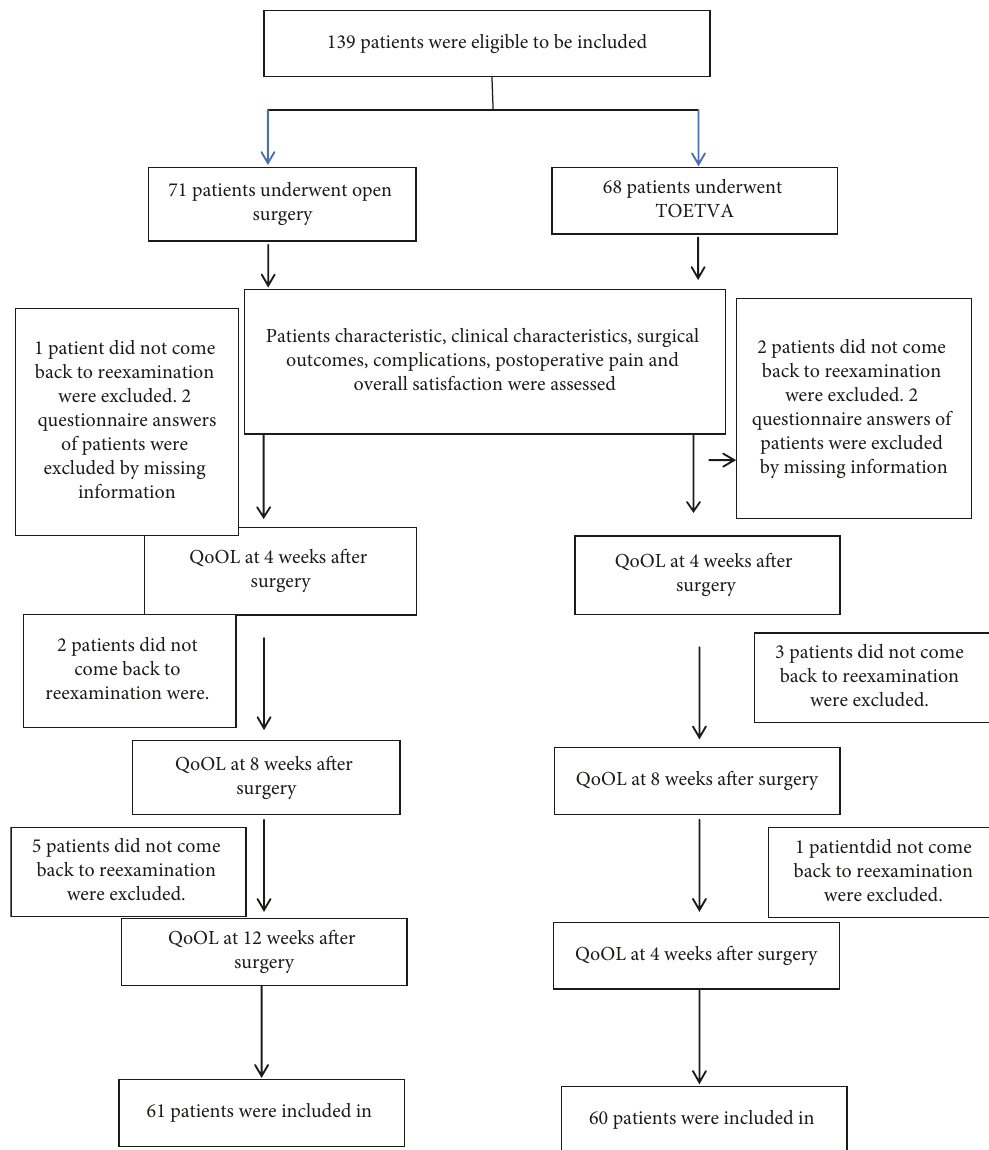
Figure 1: The flow chart of the follow-up